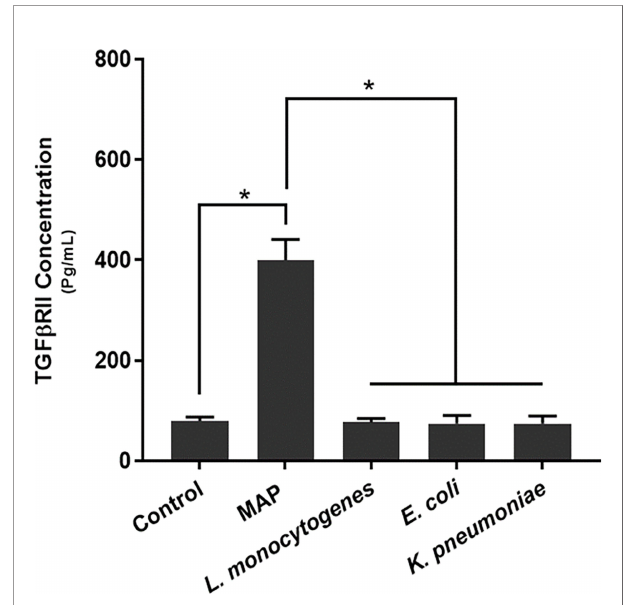
FIGURE 2 | TGF b RII shedding in bacteria infected THP-1 derived macrophages. The Kolmogorov – Smirnov normality test was used to test the normal distribution for all values and a two-way analysis of variance (ANOVA) was used to assess signi fi cance among experiments, which was followed by a Bonferroni correction test. All experiments were performed in triplicates. *Indicates P-value of <0.05.